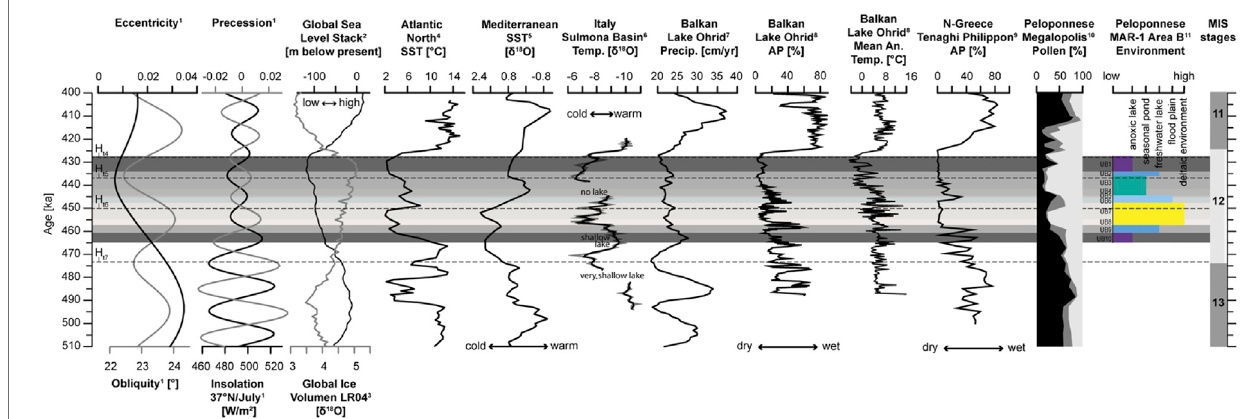
FIGURE 8 | Global records compared to the paleoenvironmental interpretation of MAR-1. 1) Orbital parameters and the local (37 ° N) mean monthly insolation (21. June – 20. July; Laskar et al., 2004). 2) Stacked global sea level curve (Spratt and Lisiecki, 2016). 3) Global ice volume based on the benthic isotope stack LR04 (Lisiecki and Raymo, 2005). 4) Mean annual SST based on planktonic foraminifera, N-Atlantic (Alonso-Garcia et al., 2011). 5) Mediterranean SST based on the δ 18 O stack of the planktonic foraminifera Globigerinoides ruber (Wang et al., 2010). 6) δ 18 O record from the Sulmona Basin, Italy (Regattieri et al., 2016). 7) Calculated precipitation model (LOVECLIM) from Lake Ohrid, Albania, North Macedonia (Wagner et al., 2019). 8) Arboreal pollen record from Lake Ohrid (Koutsodenris et al., 2019). 9) Arboreal pollen record from Tenaghi Philippon, N. Greece (Tzedakis et al., 2006). 10) Pollen record from the Megalopolis Basin, Peloponnese [black: arboreal pollen (AP); dark grey: Gramineae; bright grey: non-arboreal pollen (NAP); Okuda et al., 2002]. 11) Reconstructed paleoenvironment and lake level at MAR-1 Area B, Peloponnese (this study). The dashed line marks Heinrich-type events (H t ; Rodrigues et al., 2011). The colored shadings indicate the lithological units of